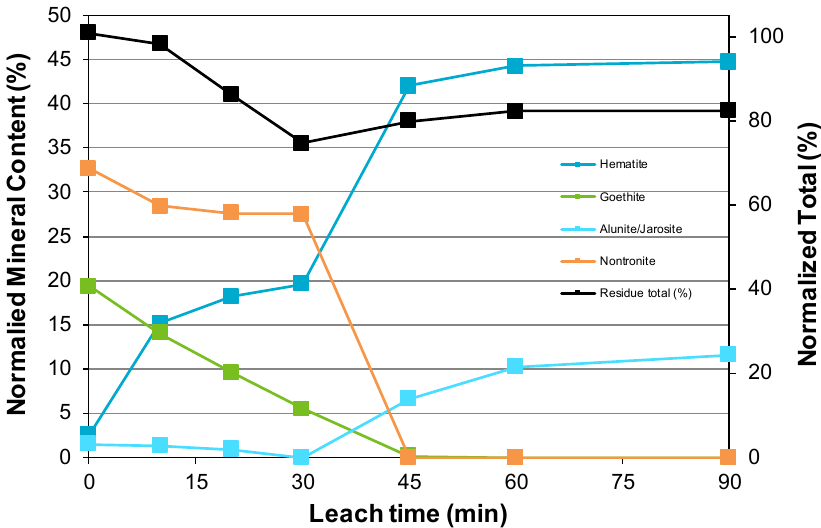
Figure 9. Changes in the composition of iron hydrolysis products in the leach residue for samples taken during the co-processing of 19.5% w / w nickel laterite ore with 10.5% w / w nickel concentrate in site water at 250 °C.